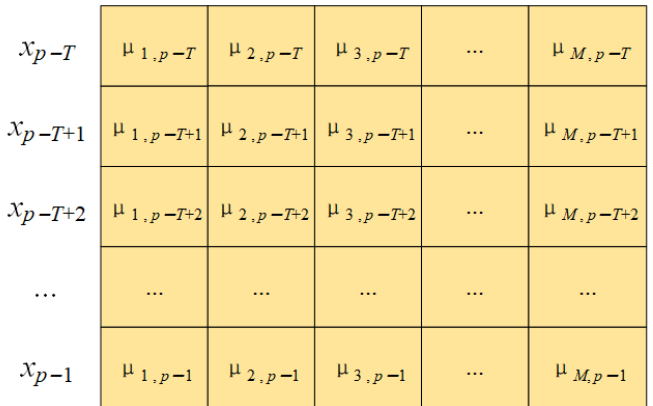
Figure 4. Structure of the model input.